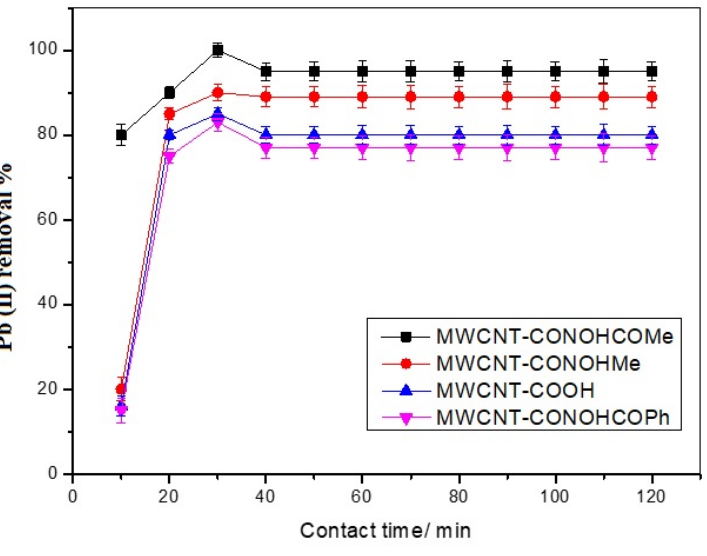
Figure 6. Effect of contact time on Pb(II) removal % using 10 mg of functionalized carbon nanotubes at pH 6 and 30 mg/L of Pb(II) at 30 °C. at pH 6 and 30 mg/L of Pb(II) at 30 ◦